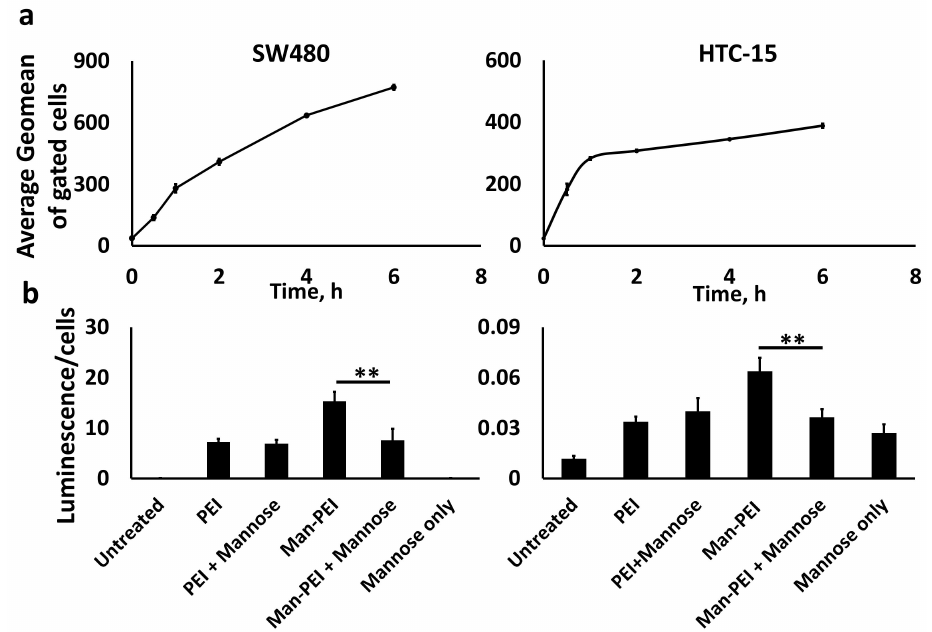
Figure 6. Flow cytometric analysis for detecting Man-PEI/plasmid complexes’ cellular uptake and competitive transfection assay. ( a ) Man-PEI-Fluorescein/plasmid complexes presented a time- dependent uptake in SW480 and HCT-15, as detected by flow cytometry; ( b ) Competition transfection analysis of Man-PEI/plasmid complexes compared to PEI/plasmid complexes. Both polymers were complexed with pGL-3 luciferase-expressing plasmid at N/P ratio 20:1. Our analysis presents the luciferase expression over cell viability for each respective sample and time point, as described in the Methods section; “+Mannose” indicates a 1-h pretreatment of the cells with free mannose prior to transfection. ** p < 0.01. One-way ANOVA with post-hoc Tukey’s